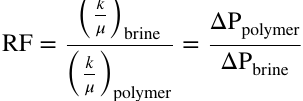
Fig. 2 Core flood procedure for oil recovery studies